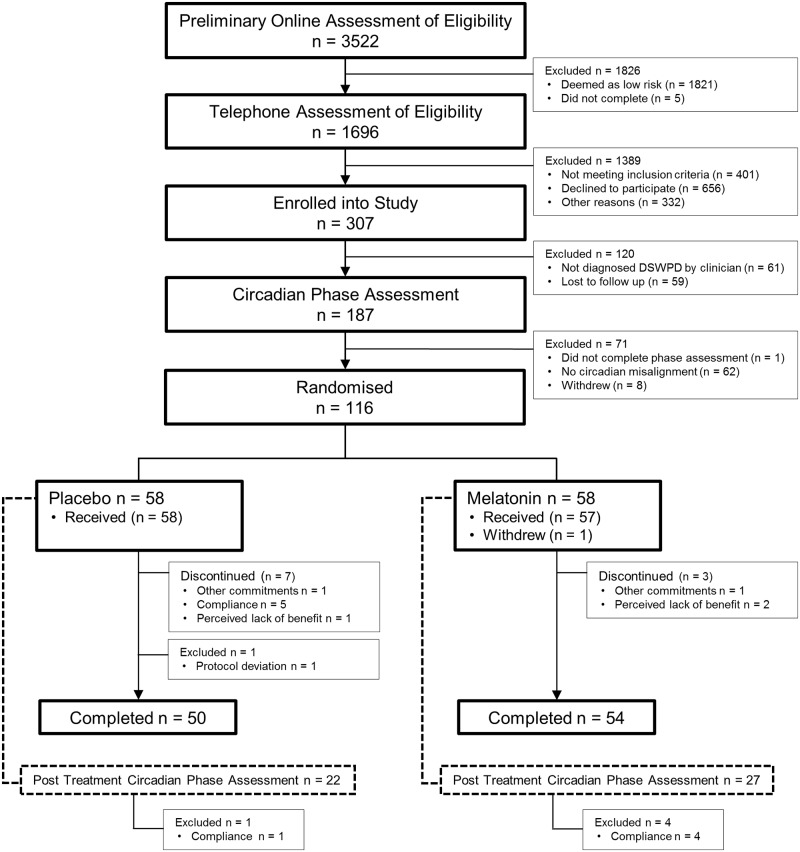
Participant recruitment and study enrolment flow chart.